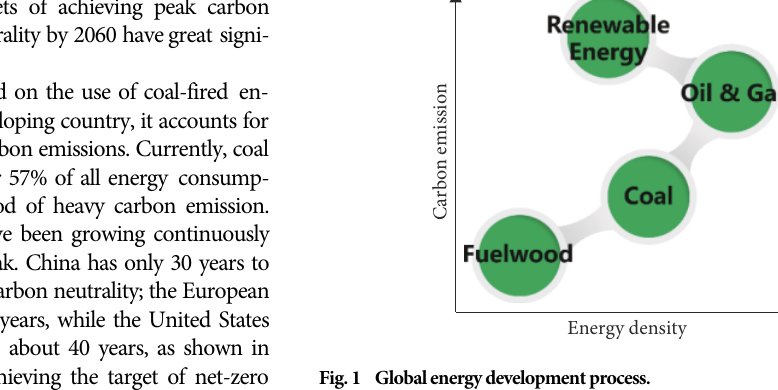
Fig. 1 Global energy development